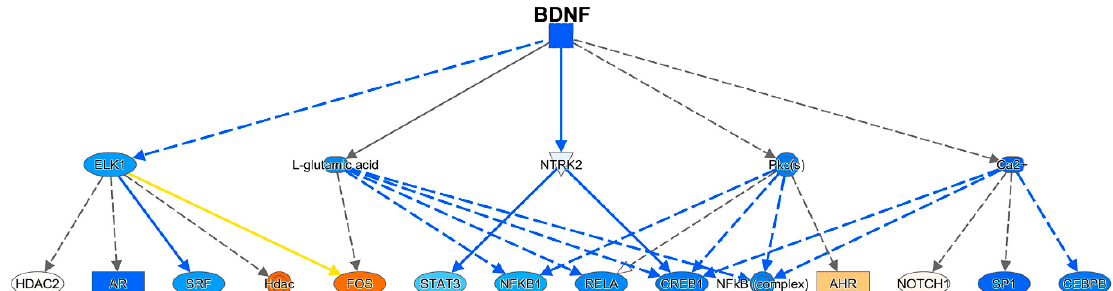
Figure 8. BDNF pathway. The colors of the symbols correspond to levels of expression or activity, with darker shades of orange indicating an increase in Meth-SIVE, and darker shades of blue decreasing in Meth-SIVE. Solid lines signify direct interactions, and dashed lines signify indirect interactions. Blue lines denote inhibitory interactions, yellow denote findings inconsistent with the state of the downstream molecule, and black lines denote that the nature of the effect is not predicted. Figure adapted from an IPA-generated diagram.